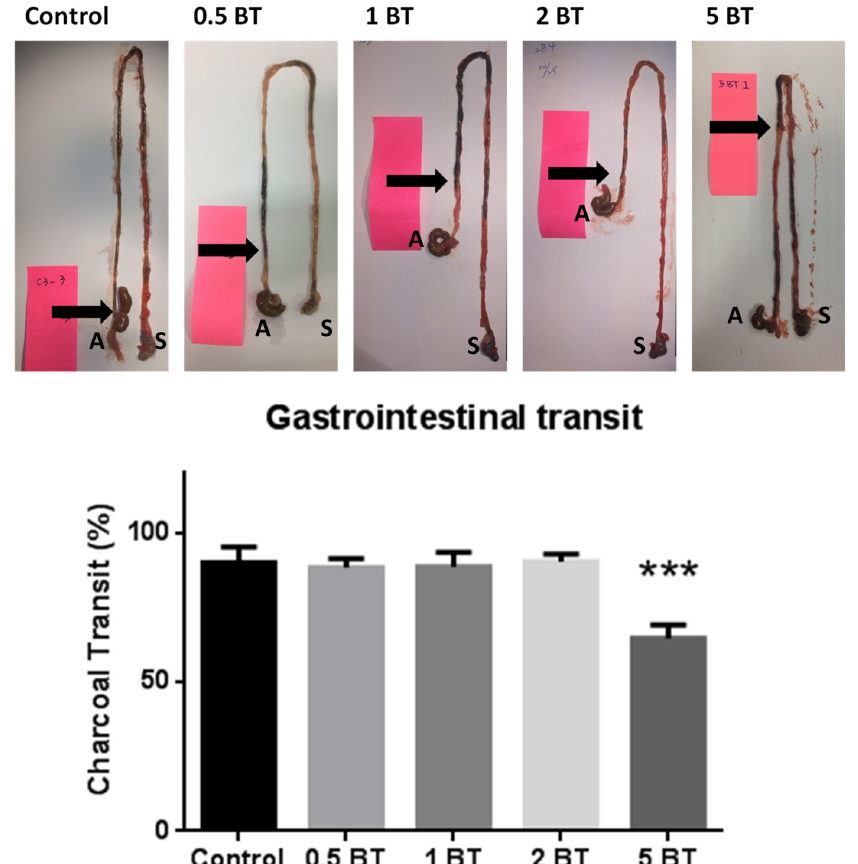
Fig 4. Effects of BT on gastrointestinal motility. The effects of drinking BT on gastrointestinal transit in the five groups of mice (n = 10). Black arrows indicate the intestine traversed by the charcoal marker. S, Stomach; A, appendix. Only 5 BT decreased gastrointestinal transit. The data are mean ± SEM and analyzed by one-way ANOVA. ��� P < 0.001.